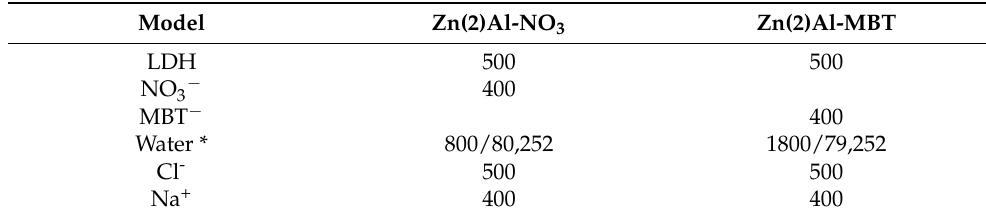
Table 1. Composition of the LDH systems studied in this